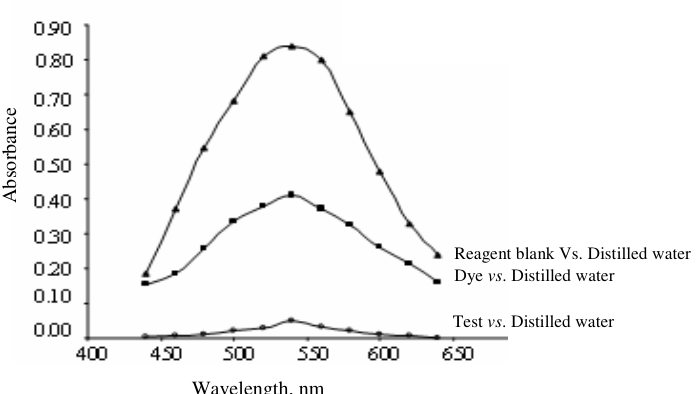
Figure 2. (a) CEFT - NBS/CB system; Absorption